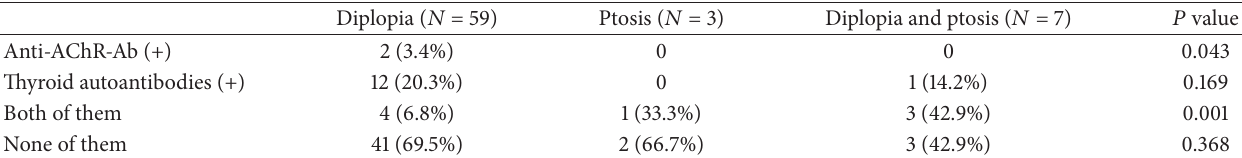
Table 4: The prevalence of anti-acetylcholine receptor antibody (anti-AChR-Ab) and thyroid autoantibodies in the three groups. Diplopia ( 𝑁 = 59) Ptosis ( 𝑁 =